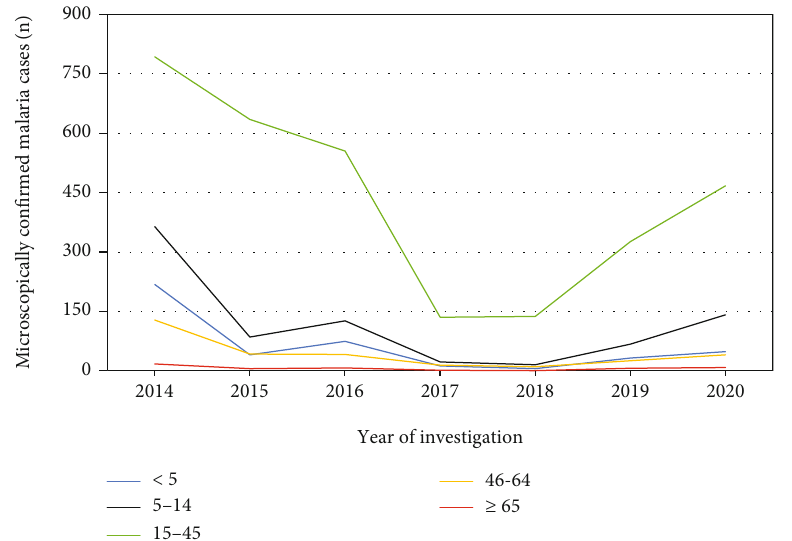
Figure 3: Trend analysis of malaria in relation to participants ’ age from 2014 to 2020 ( n = 28217